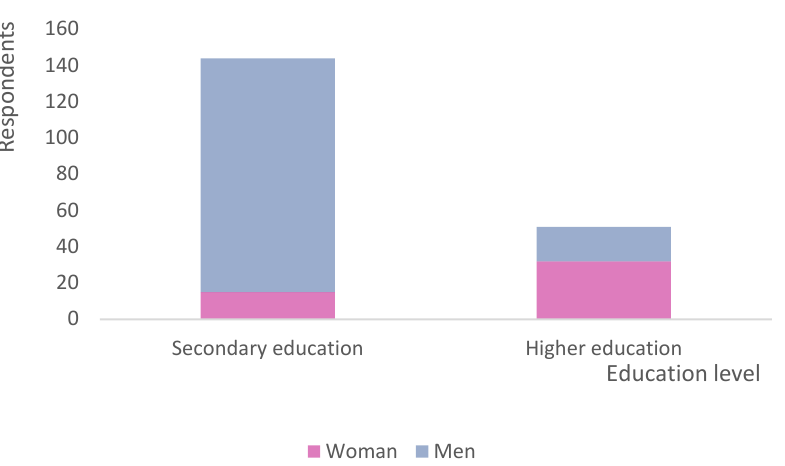
Figure 4. Structure of the level of education of the respondent.